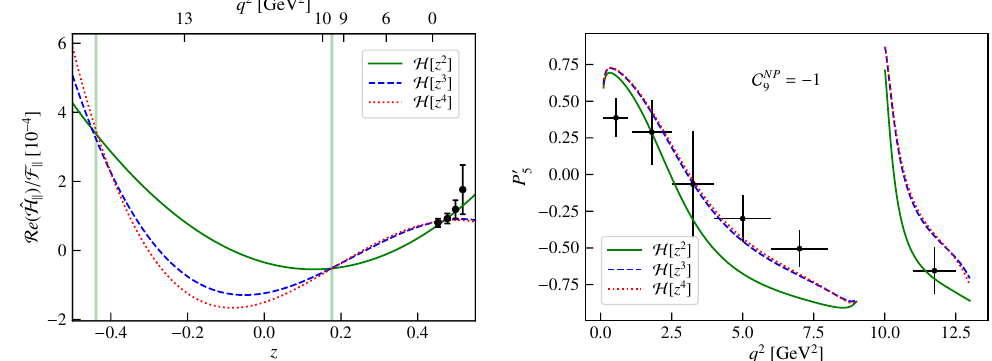
Figure 4 . Left: Re ^ H ( z ) = F ( z ) corresponding to the set of parameter f (cid:11) ( k ) k k tion of the ensembles in the di(cid:11)erent hypotheses as described in the text. Right: projection of the di(cid:11)erent hypotheses in the P 0 angular observable, all the three con(cid:12)gurations assumes the BMP 5 scenario. The result of the LHCb Run I analysis [2] is overlaid as reference. LHCb Run II LHCb Upgrade [50 fb (cid:0) 1 ]